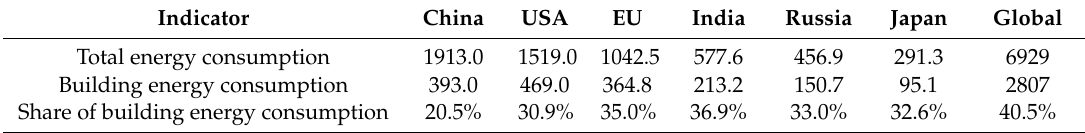
Table 4. An international comparison of building energy consumption, Mtoe (million tons-oil-equivalent).